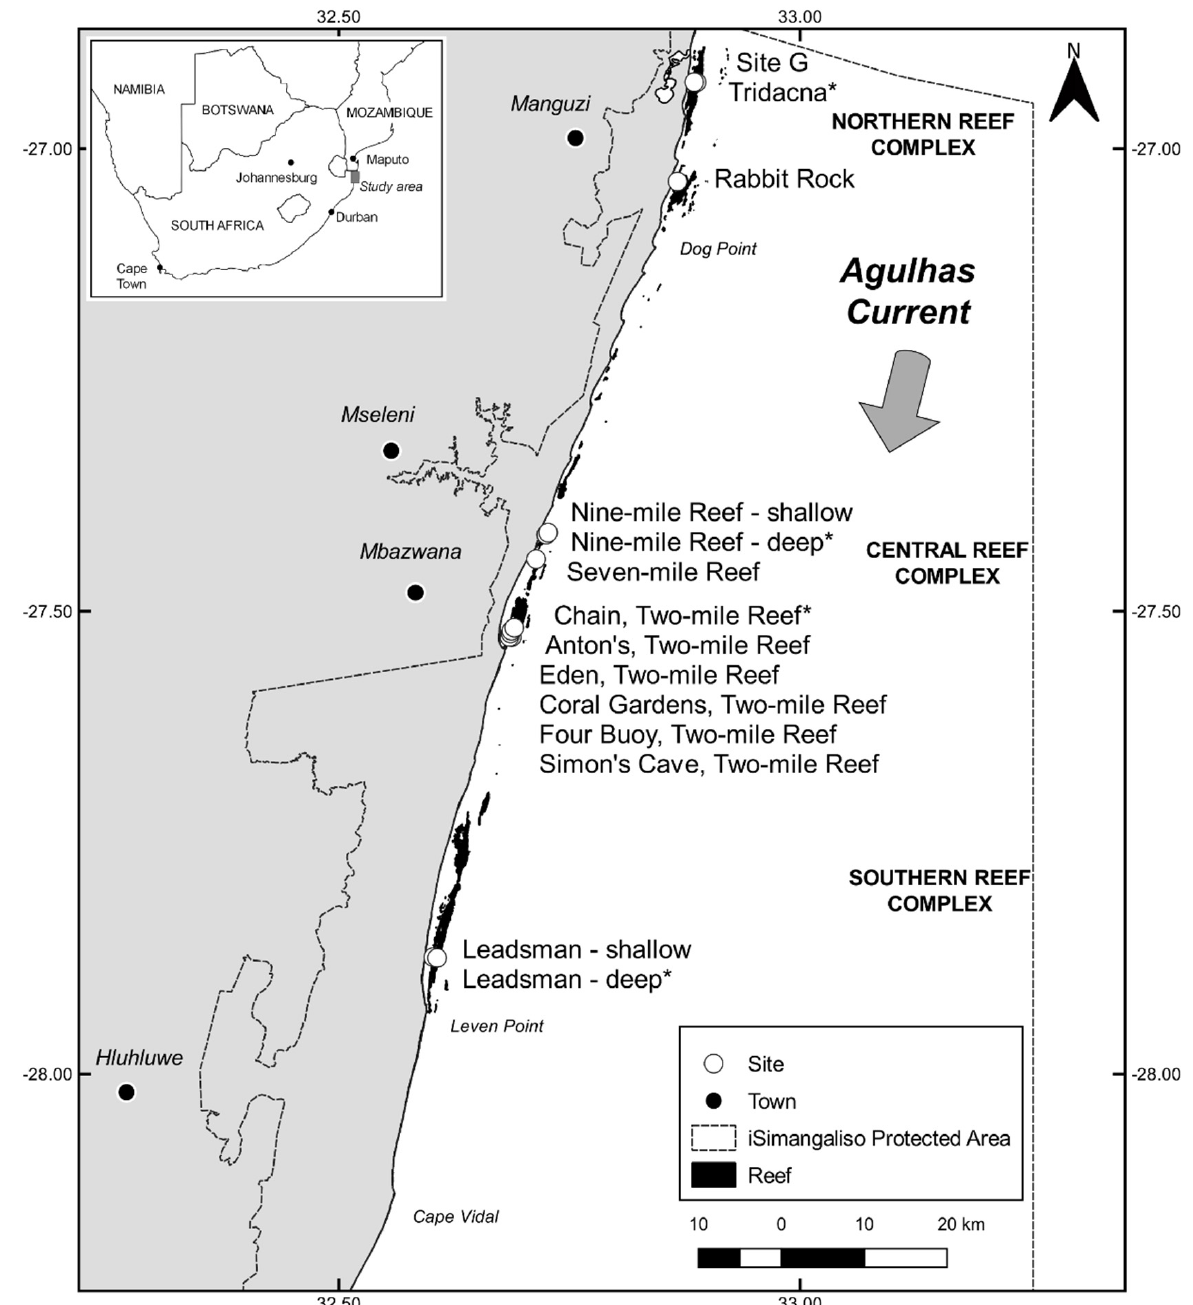
Figure 1. Coral reefs in the southwestern Indian Ocean of the Maputaland region of South Africa indicating study sites where bleaching surveys were conducted. * indicates sites where underwater temperature recorders were present.